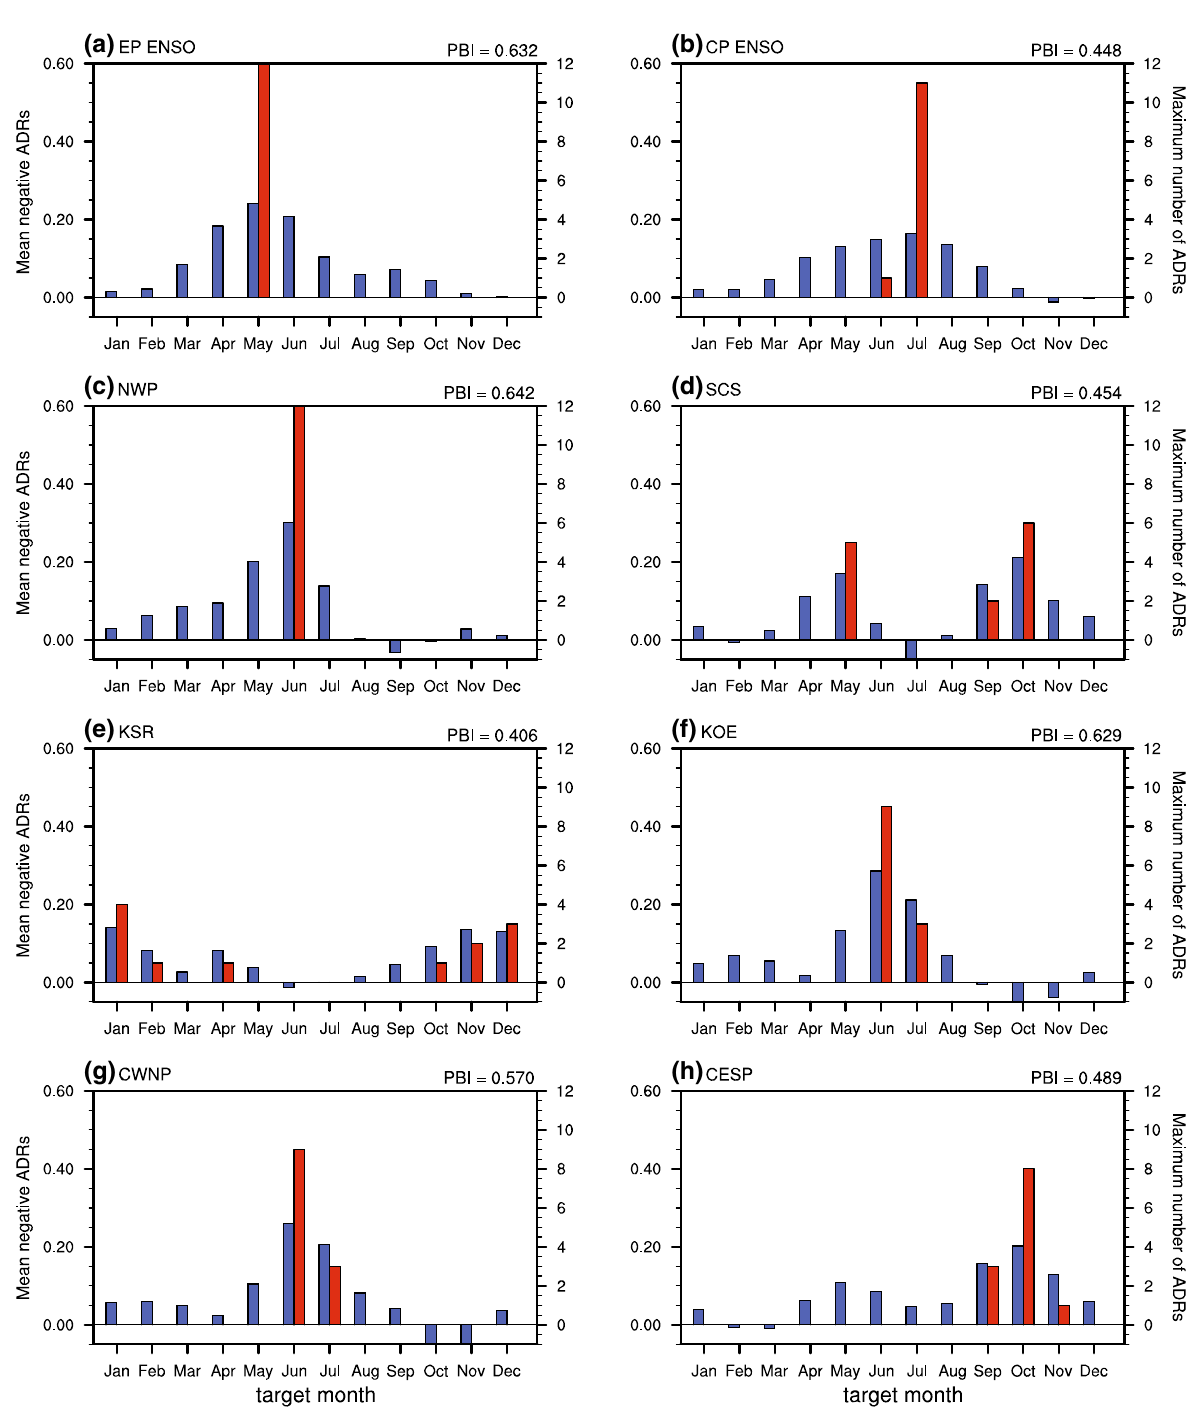
Fig. 3 Mean ADRs for all 12 lead months (left y axis) and the frequency of the maximum ADRs (right y axis) as a function of the target calendar month (x axis) for the a EP ENSO, b CP ENSO, c Northwestern Pacific (NWP), d northern South China Sea (SCS), e Kuroshio Source Region (KSR), f Kuroshio–Oyashio Extension region (KOE), g central‑western North Pacific (CWNP), and h central‑eastern South Pacific (CESP). Blue bar is the mean ADRs for all 12 lead months (left y axis), and red bar is the frequency of the maximum ADRs (right y